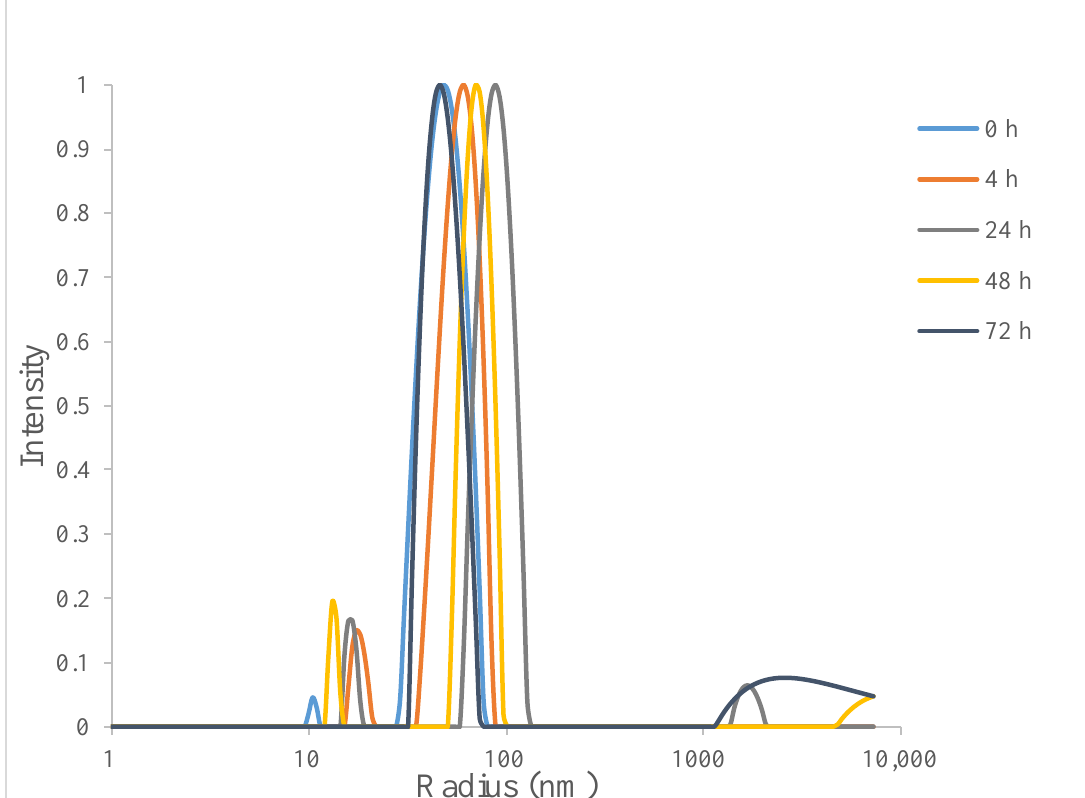
Figure 4. Effect of catalyst impregnation time in ethanol on Pd particle size distribution. Impregnation conditions: i -Pd(OAc) 2 (TPPTS) 2 (10 µ mol, Pd), 5 mL ethanol, 60 ◦ C, 1 atm